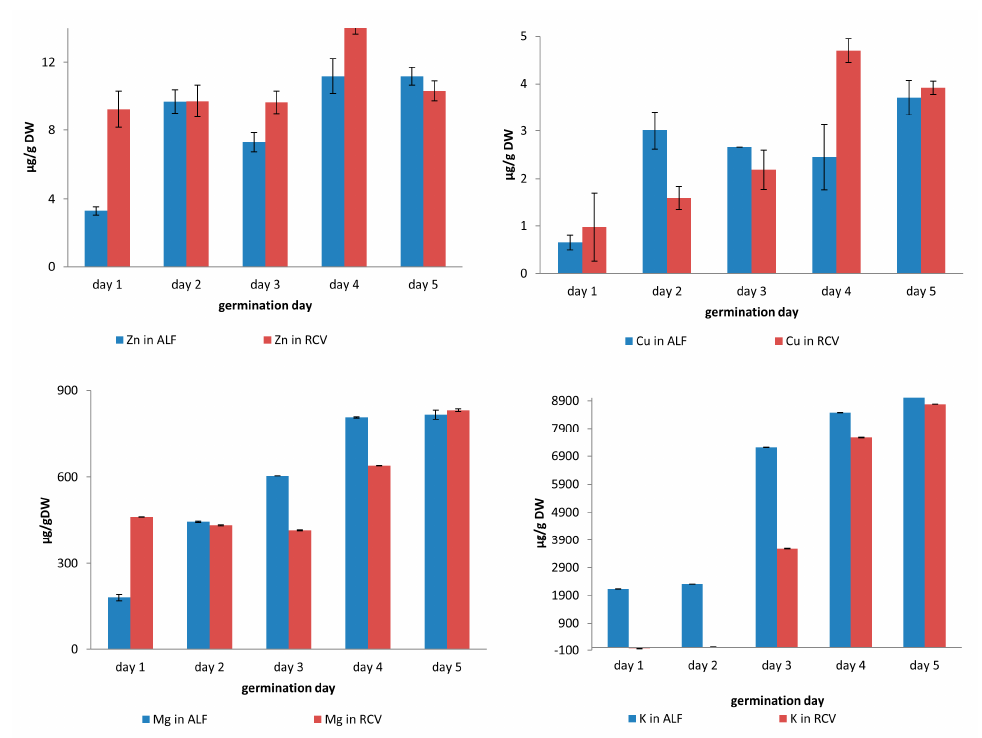
Figure 2. Relative change per day in Zn, Cu, Mg, and K content in sprouts of ALF and RCV during germination, compared to row seeds.